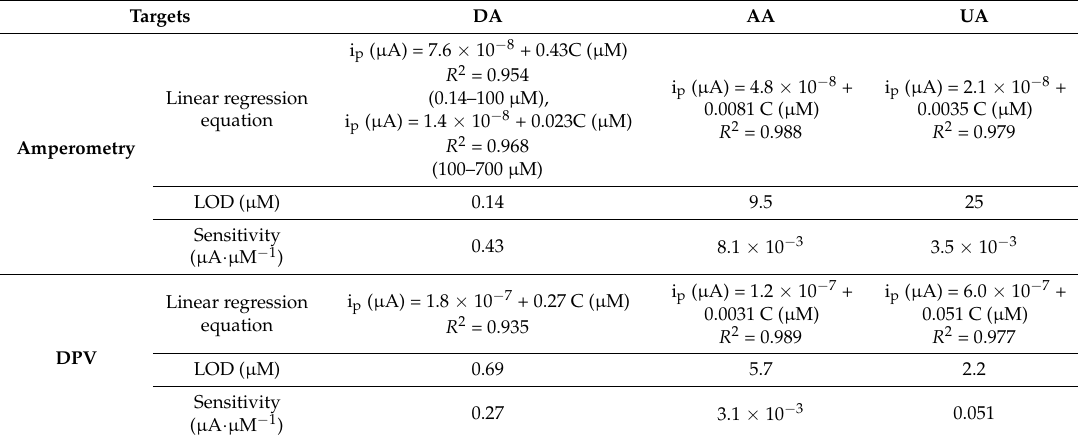
Figure 8. Amperometric responses of RGO/AuNPs-GCE to successive addition of ( a ) DA, ( b ) AA, and ( c ) UA in 0.1 M PBS (pH 7.4) under stirring. Working potentials were 0.2, − 0.02, 0.265 V (vs. Ag/AgCl reference electrode) for DA, AA, and UA, respectively. Calibration plot of steady-state currents obtained at the RGO/AuNPs-GCE against concentrations of ( d ) DA, ( e ) AA, and ( f ) UA. Table 1. Comparison of limits of detection (LOD) and sensitivity values with respect to DA, AA, and UA as determined by amperometric and DPV analysis.